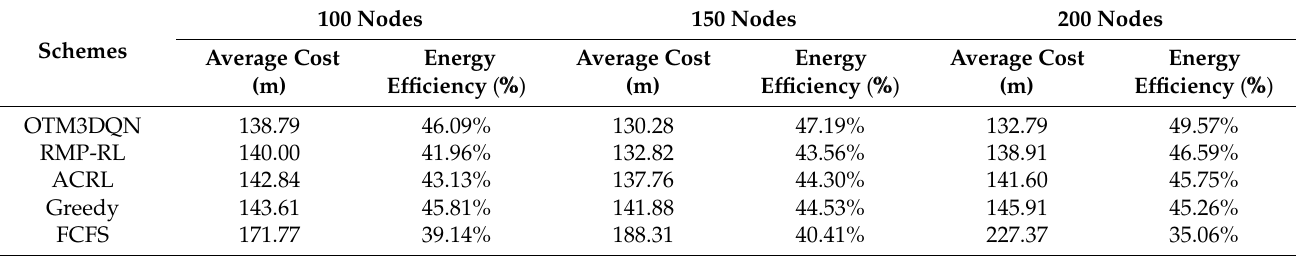
Table 4. Average charging cost and energy